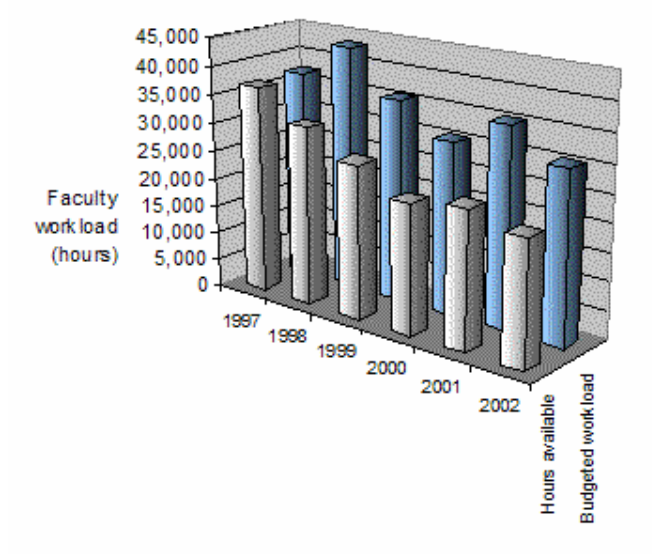
Figure 1. Excess of total hours worked beyond notional ‘normal academic workload,’ Faculty of Rural Management, University of Sydney, 1997–2002. (Data refer to hours worked by full time and part time “permanent” staff, but excludes